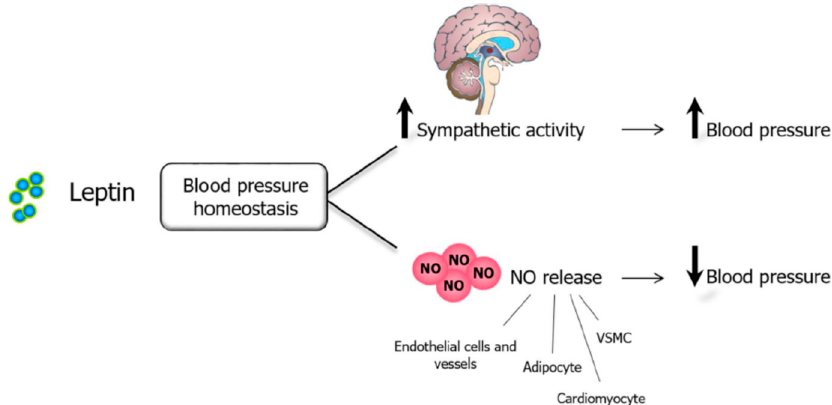
Figure 4. Leptin, NO, and blood pressure. Leptin exerts a dual influence on blood pressure control. Leptin activates sympathetic activity by centrally acting mechanisms, thus increasing blood pressure. However, direct leptin effects on peripheral tissues (endothelial cells, VSMC, adipocytes, cardiomyocytes, among others) lower blood pressure through increased NO release. NO, nitric oxide. VSCM, vascular smooth muscle cell.